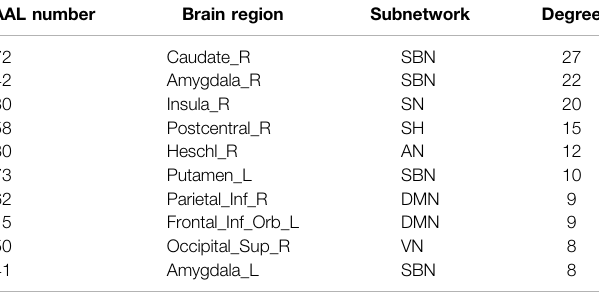
TABLE 6 | Top-10 brain regions corresponding to consensus degree based on the PC methods. AAL number